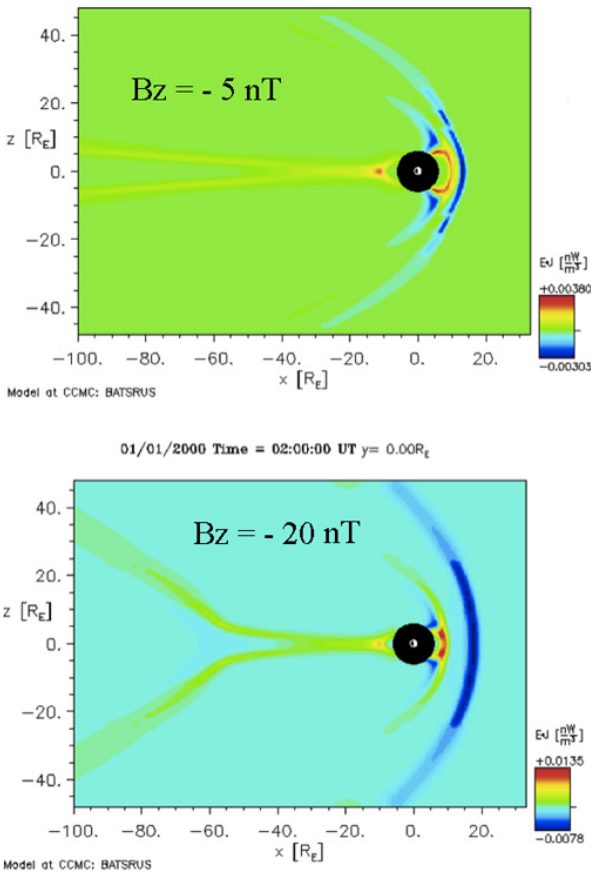
Fig. 4. Distribution of J • E in the meridional plane from BAT- SRUS simulations for solar wind with V = 400kms − 1 , n = 5cm − 3 and purely southward